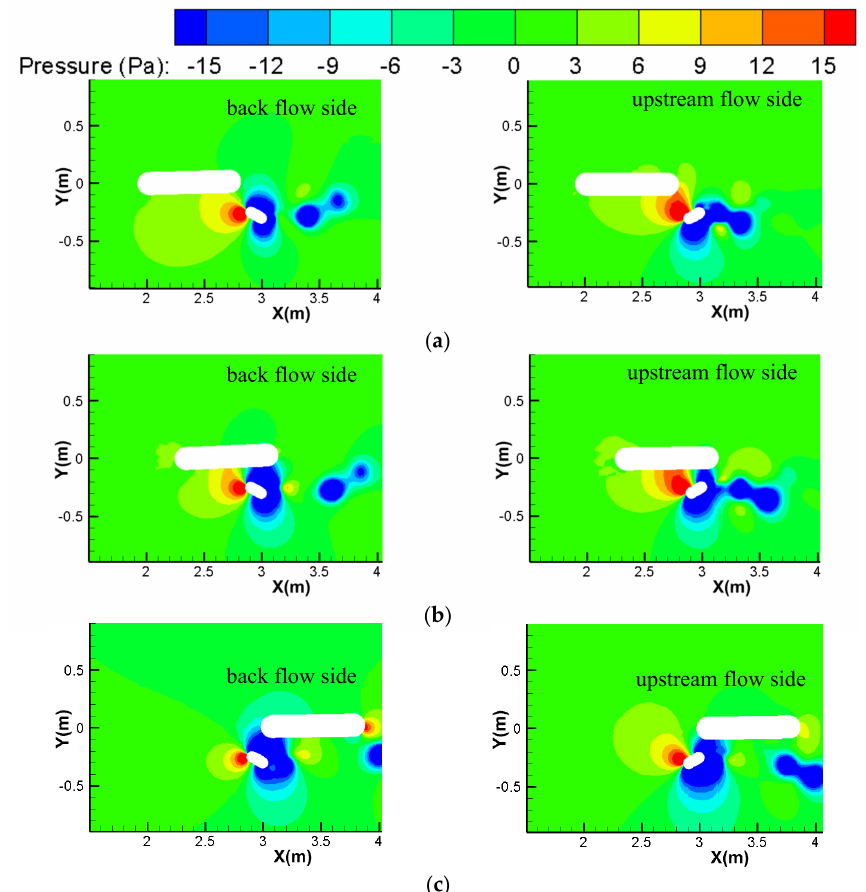
Figure 30. Diagrams of the water pressure distribution of the ship passing the left and right sides of the round-ended pier with α = 30°: ( a ) Ship bowled up to the pier; ( b ) Bow moving past the pier; ( c ) Stern sailing past the pier.